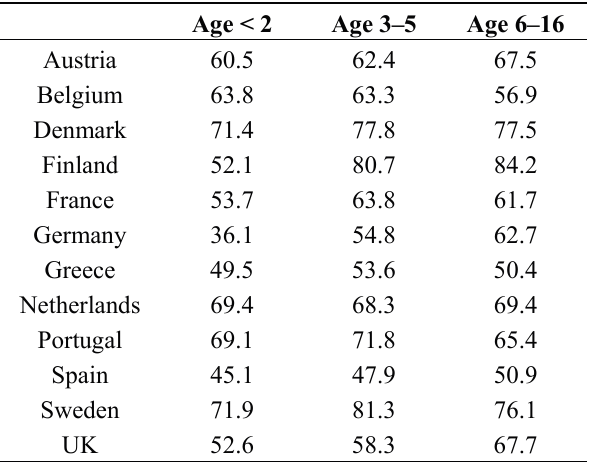
Table 2. Employment rates among mothers with the youngest child under 3 years old, 3 to 5 years old, and 6 to 16 years old in